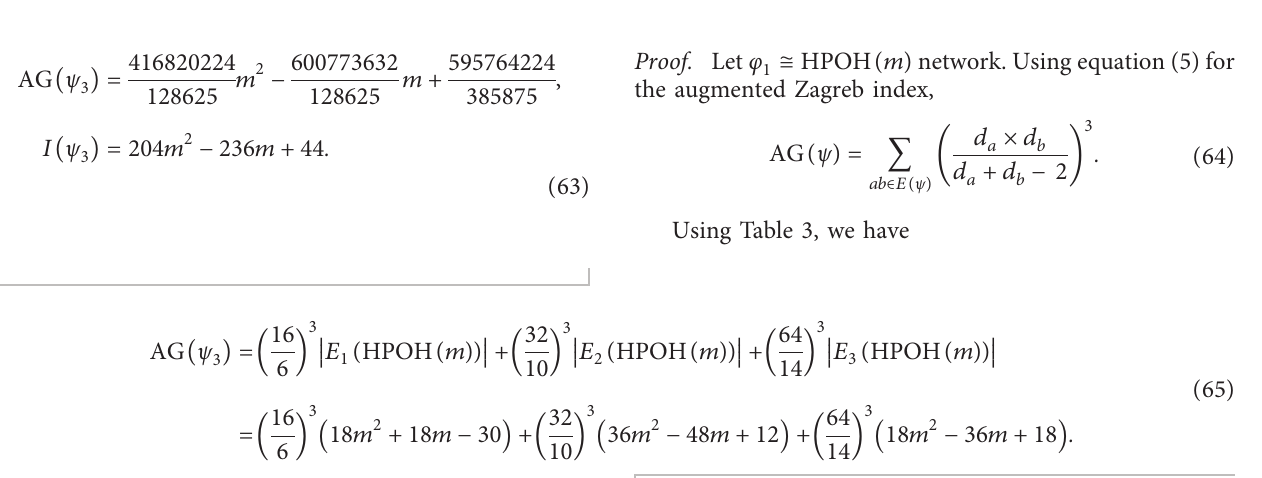
Figure 5: For POH